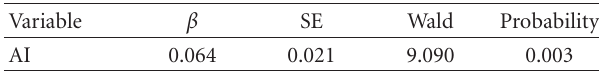
Table 5: Cox hazard stepwise regression analysis for cardiovascular